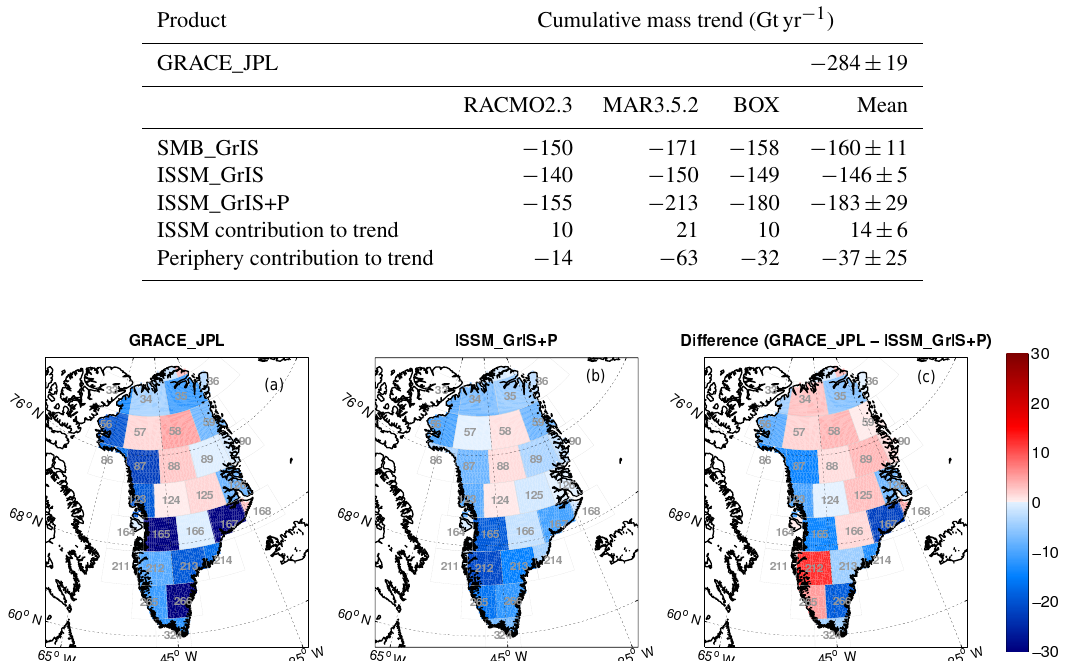
Table 1. Cumulative mass trends (Gtyr − 1 ) for anomalies of the individual RCM SMB products (SMB_GrIS), ISSM forced with each individual RCM SMB product (ISSM_GrIS), and ISSM_GrIS plus cumulative mass estimates for the ice sheet periphery (ISSM_GrIS+P) are presented in the left three columns. Presented in the right column are the mean cumulative mass trend and trend uncertainty for each time series (see also Fig. 3a). Also reported for each of these columns are the total ISSM contribution to the ISSM_GrIS+P trend (the SMB-driven dynamics predicted by ISSM, calculated as the difference between SMB_GrIS and ISSM_GrIS) and the total periphery contribution to the ISSM_GrIS+P trend (the sum of SMB calculated over peripheral permanent ice defined in Fig. 1). Along with the trends, 1 σ uncertainties (see Sect. 5) are displayed.